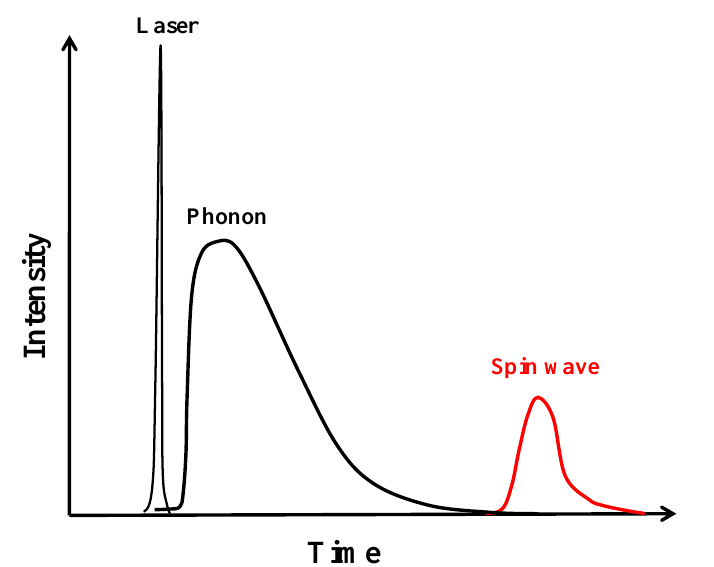
Figure 2. Schematic temporal profile of laser excitation, phonon scattering, and spin wave scattering. In the figure, the difference of Stokes phonon and Stokes spin wave is presented.